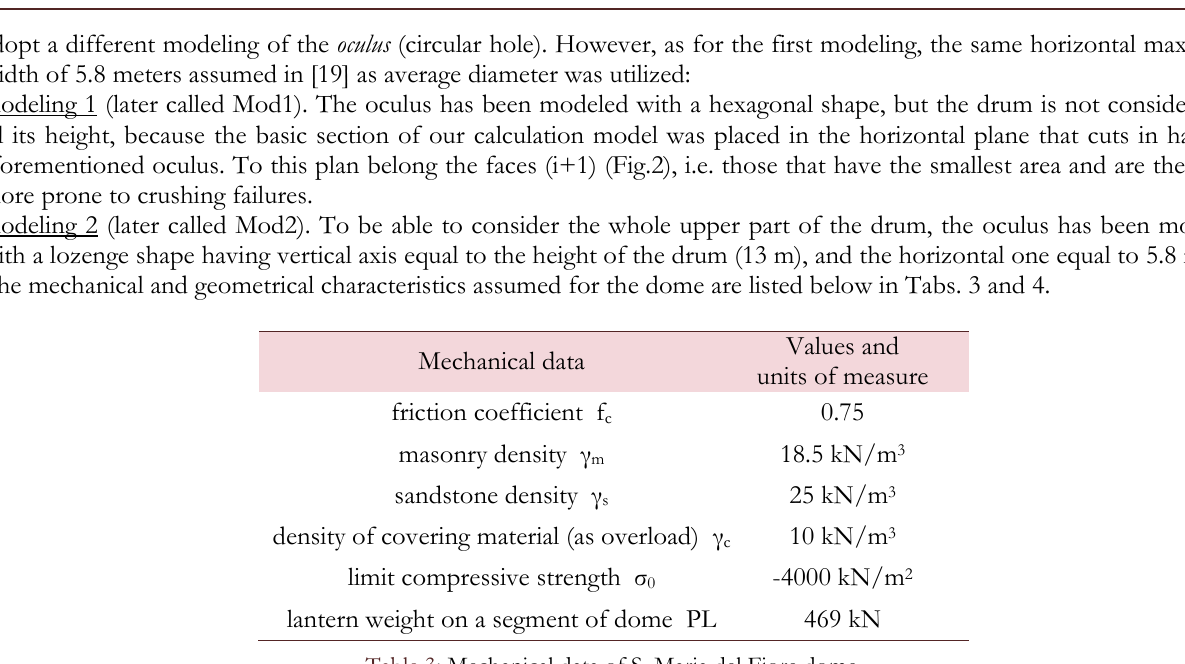
Table 3: Mechanical data of S. Maria del Fiore dome.